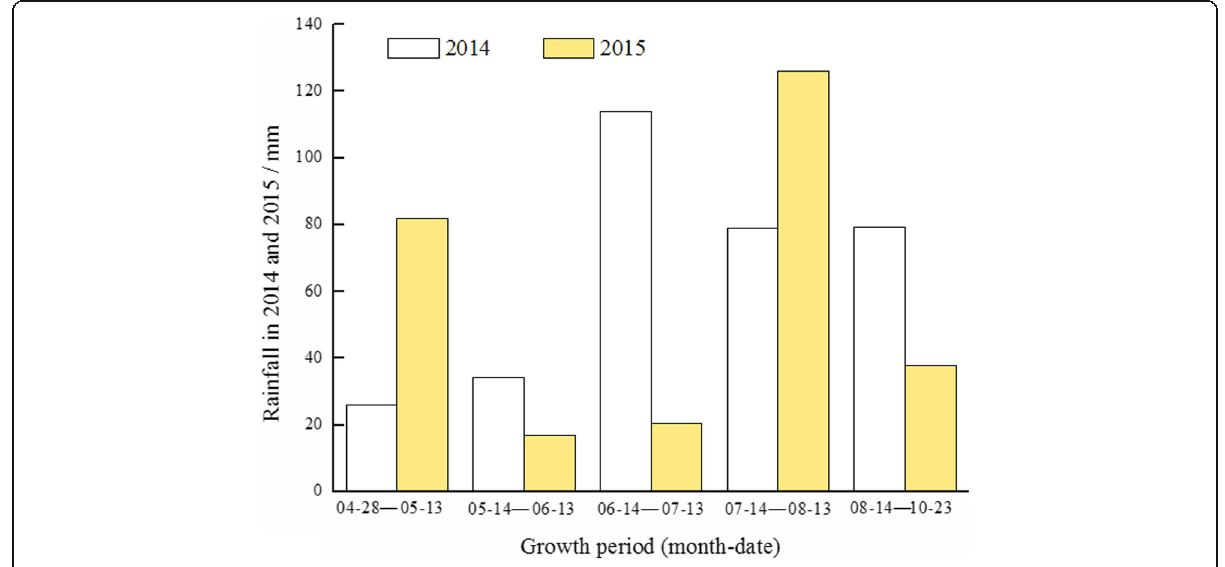
Fig. 1 Rainfall during the cotton growth stages in 2014 and